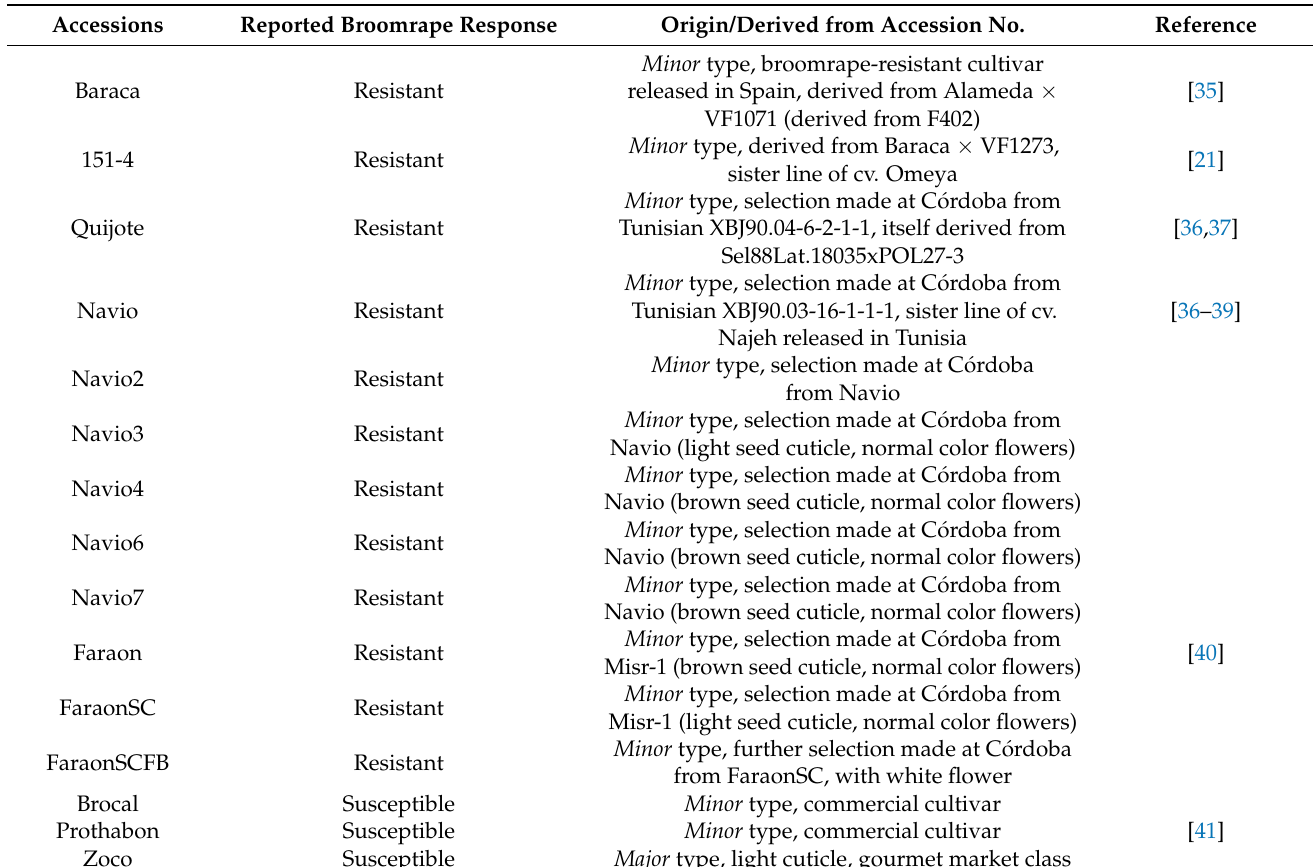
Table 1. Faba bean accessions included in the study.